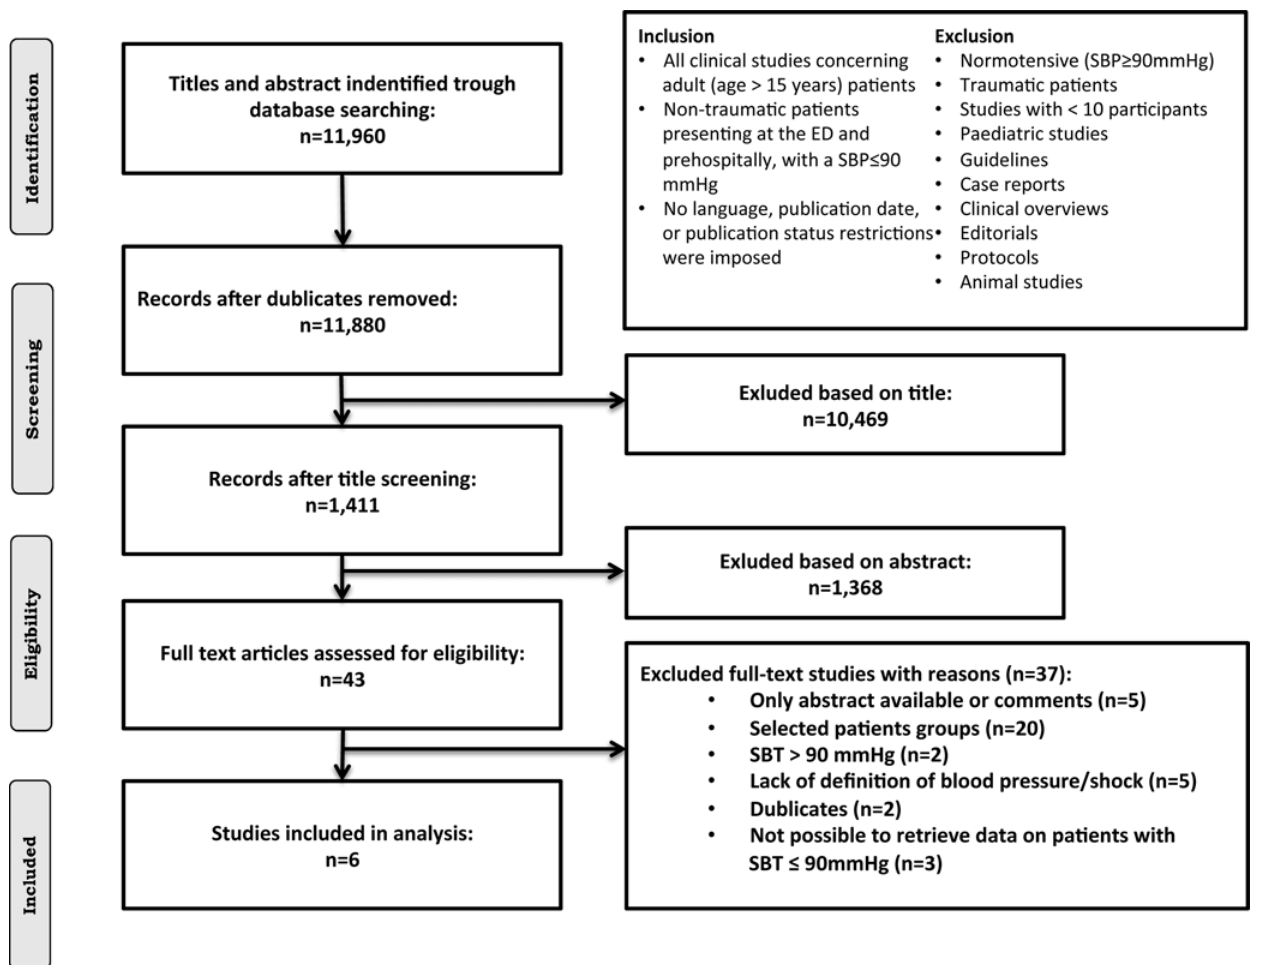
Fig 1. Inclusion and exclusion criteria and study flow for the systematic